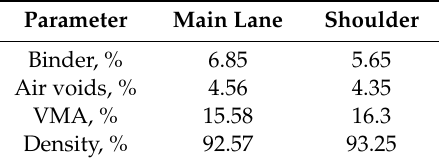
Table 2. Summary of Quality Assurance (QA) test